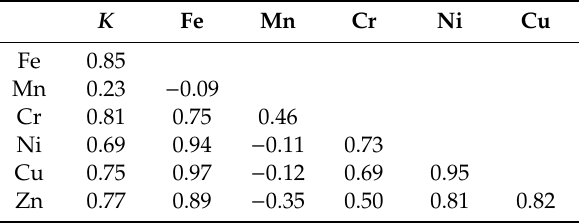
Table 13. Correlation matrix of magnetic susceptibility and the contents of chemical elements in the soils of the residential zone of Gubakha, n = 10, p = 0.05. K Fe Mn Cr Ni Cu Fe 0.71 Mn − 0.33 − 0.62 Cr 0.70 0.78 − 0.39 Ni 0.71 0.91 − 0.71 0.67 Cu 0.51 0.63 − 0.76 0.30 0.81 Zn − 0.15 − 0.02 − 0.40 − 0.24 0.22 0.47 Table 14. Correlation matrix of magnetic susceptibility and the content of chemical elements in the soils of the industrial zone in the area of OAO “Gubakhinsky coke”, n = 10, p = 0.05. K Fe Mn Cr Ni Cu Fe 0.85 Mn 0.23 − 0.09 Cr 0.81 0.75 0.46 Ni 0.69 0.94 − 0.11 0.73 Cu 0.75 0.97 − 0.12 0.69 0.95 Zn 0.77 0.89 − 0.35 0.50 0.81